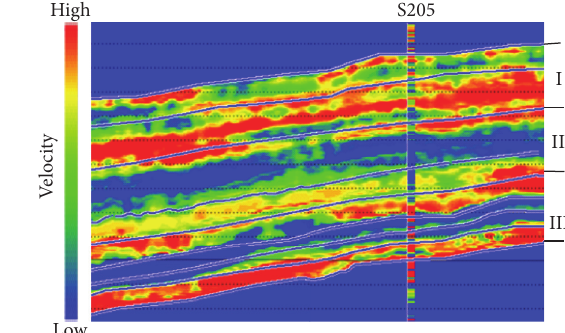
Figure 5: KELM-based inverted velocity section crossing well